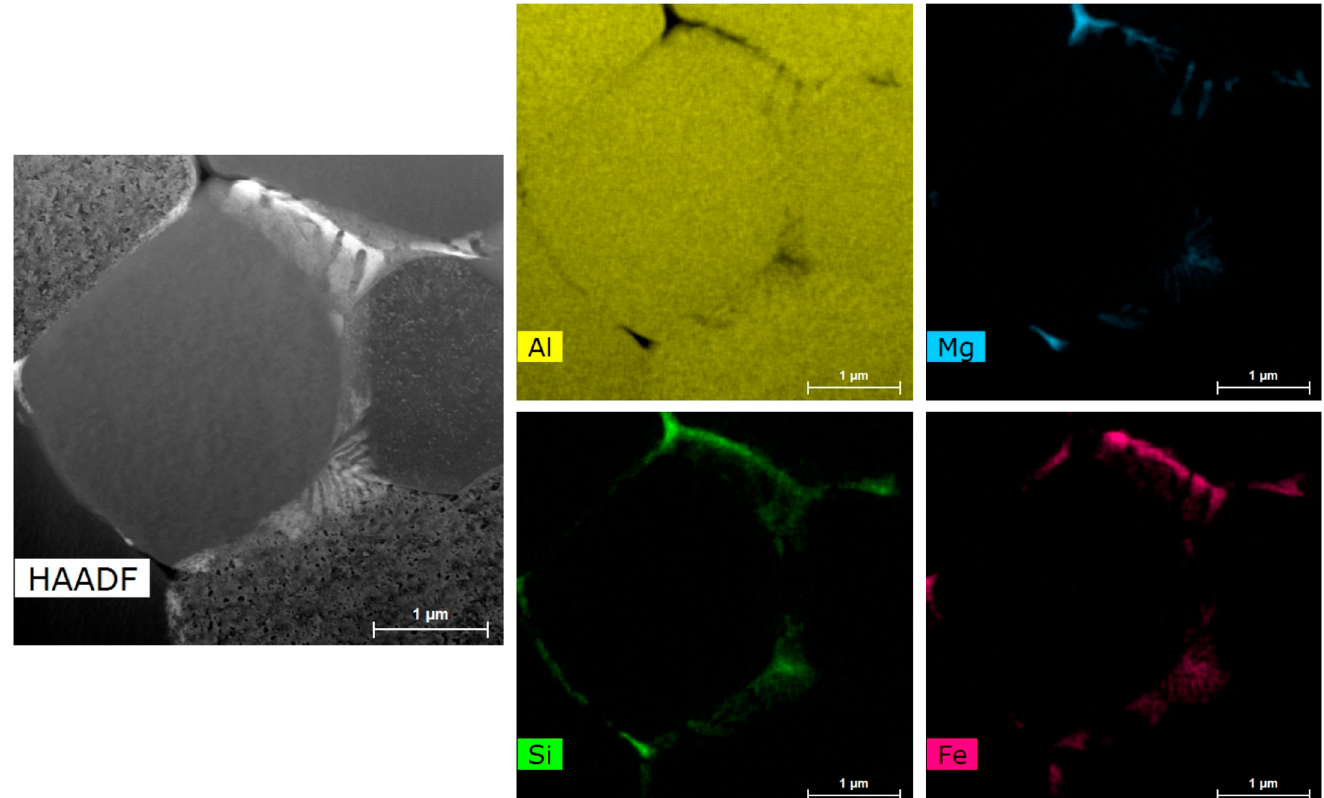
Figure 6. The subfigure labeled with “HAADF” presents a HAADF-STEM micrograph affiliated with a subset of subgrains and sub-granular boundary regions for an as-atomized Al 6061 powder particle. The colored micrographs labeled with Al, Mg, Si, and Fe present the respective EDS-derived elemental maps for the area presented in the HAADF micrograph. Note that the scale bars are all 1 μ m.